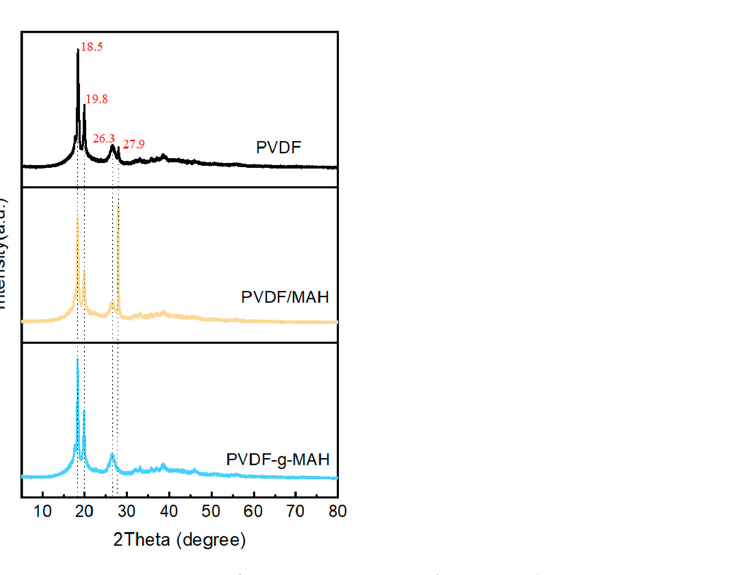
Figure 8. XRD patterns of pure PVDF, PVDF/MAH and PVDF-g-MAH (G = 0.63%).